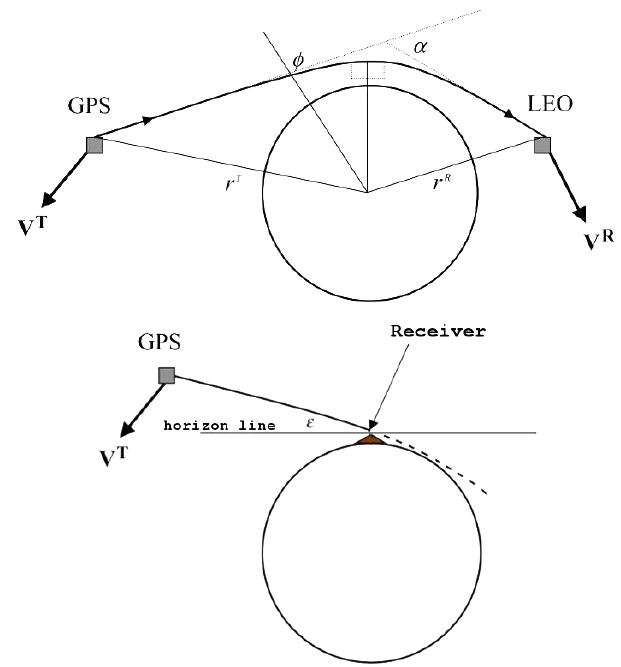
Figure 2. Top panel: standard radio occultation geometry. Bottom panel: GPS-receiver radio link in an on-ground receiver geometry, such as the one used in this experiment. (cid:15) indicates elevation. Figure adapted from Healy et al.